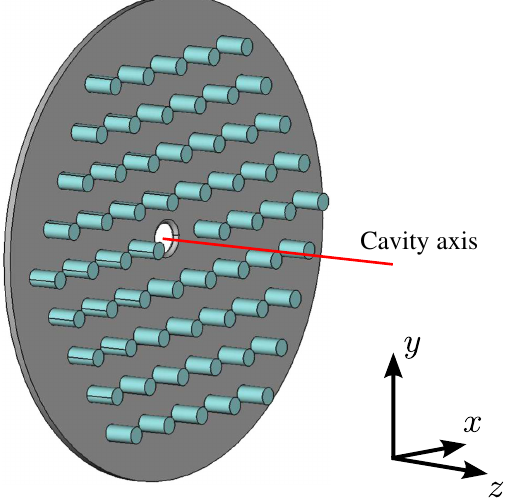
FIG. 4. The triangular lattice PhC of sapphire rods confines the accelerating mode to the cavity axis while damping